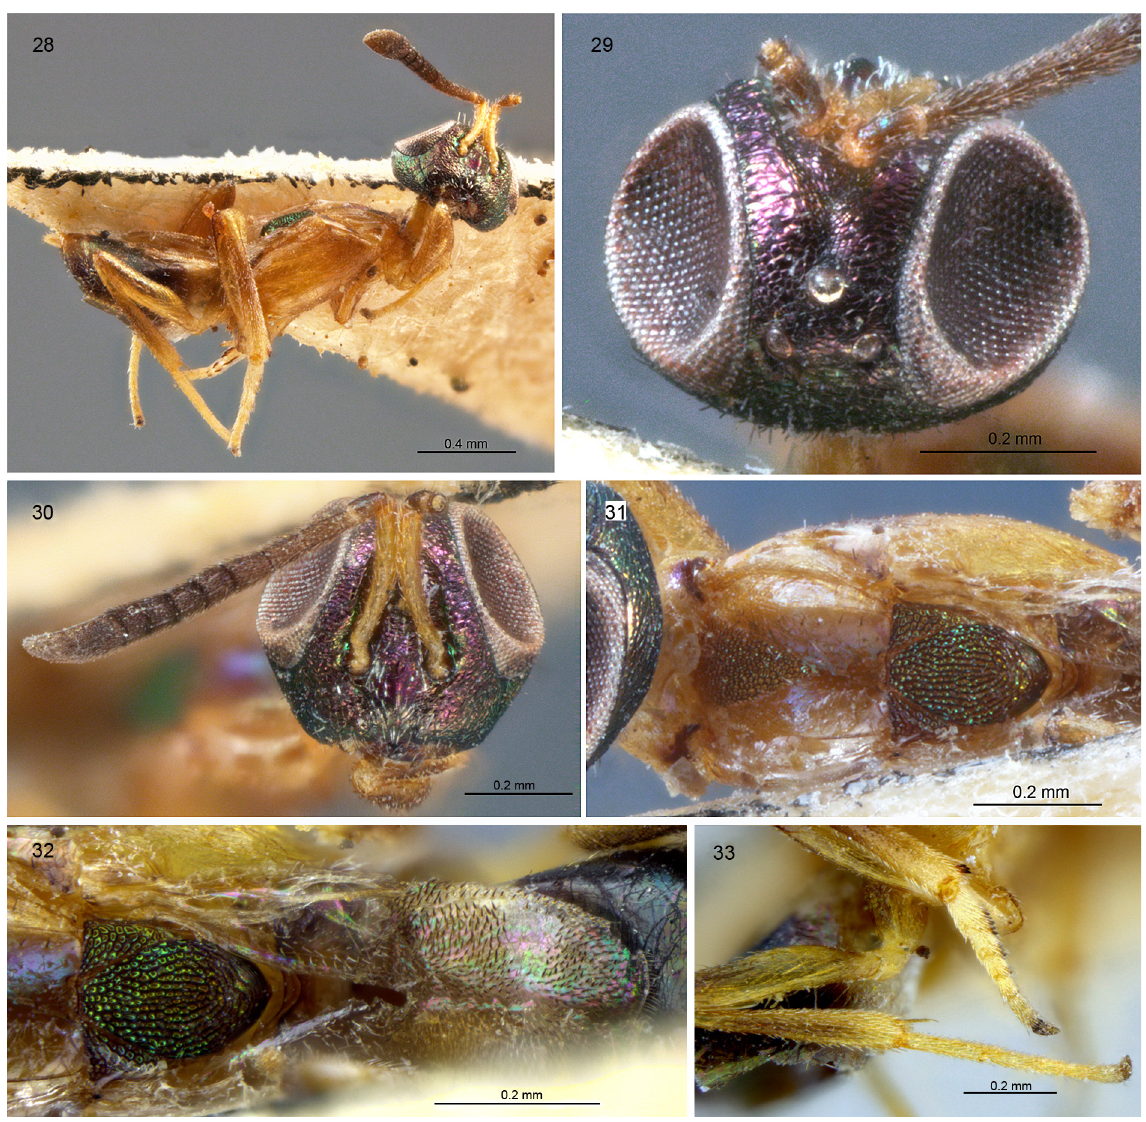
Figs 28–33 . Anastatus huangi Sheng & Yu, 1998, holotype, ♀. 28 . Body, lateral view. 29 . Head, frontodorsal view. 30 . Head, frontal view. 31 . Mesosoma, dorsal view. 32 . Scutellar-axillar complex and fore wing, dorsal view. 33 . Middle and hind